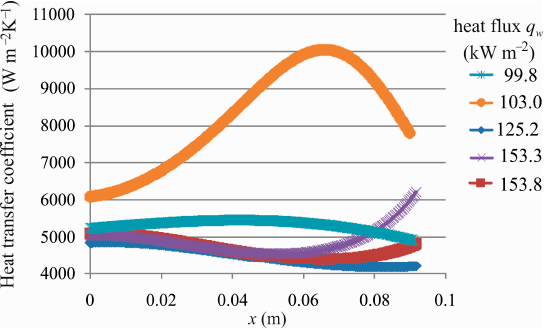
method are shown in Figure 8. The heat transfer coefficients take values from 4000 Wm − 2 K − 1 to 6000 Wm − 2 K − 1 and, except one case described below, show low variability along the mini-channel length.